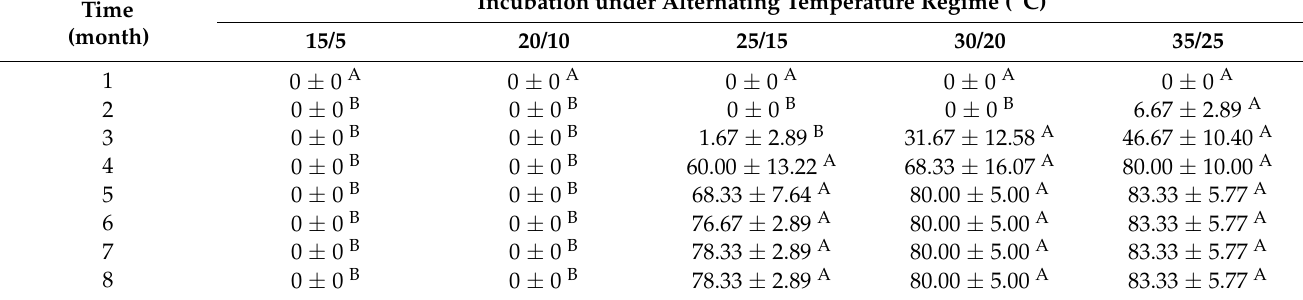
Table 2. Percentage of cumulative shoot emergence (mean ± SD) in Quercus chungii seeds under different tempera- ture regimes.